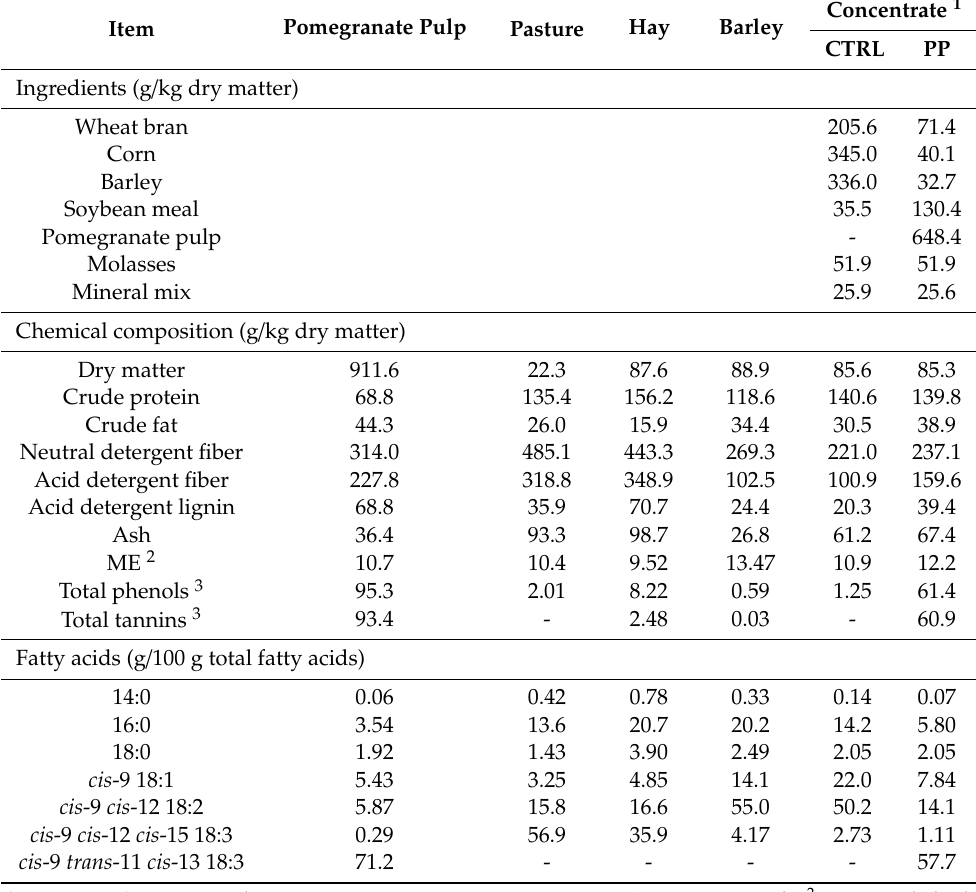
Table 1. Ingredients and chemical and fatty acid composition of pomegranate pulp, basal diet (pasture, hay, and barley), and experimental concentrates fed to the lactating